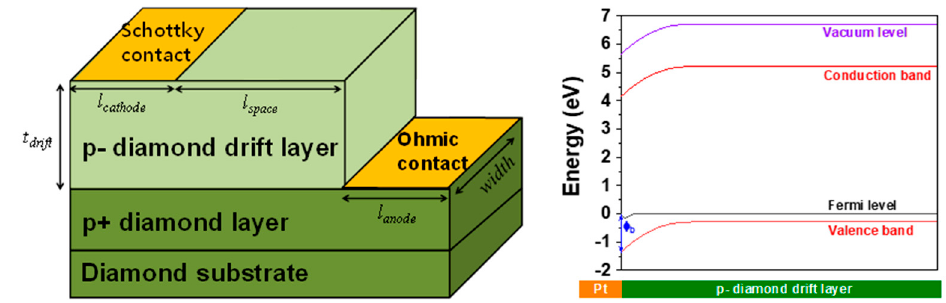
Figure 1. Cross-sectional view of the p-type diamond pseudo-vertical Schottky barrier diode (SBD) for forward current–voltage (I–V) and breakdown voltage. Simulated energy band at the Schottky contact / p- diamond drift layer at 300 K is also shown.